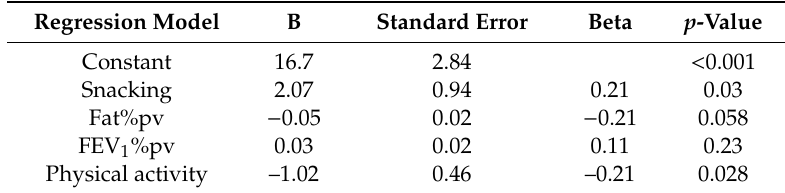
Figure 2. Association between body mass index (BMI) percentile and risk factors for obesity in all studied groups (adjusted R 2 = 0.97; p < 0.05). %F: percentage of body fat; FEV 1 : forced expiratory volume in one second. Legend: red line means < 25th percentile, black line 25 th –89th percentile, grey line 90 th –97th percentile and yellow line >97th percentile. Table 4. Multivariate regression model predicting BMI value (adjusted R 2 of the model was 0.97, p < 0.05).